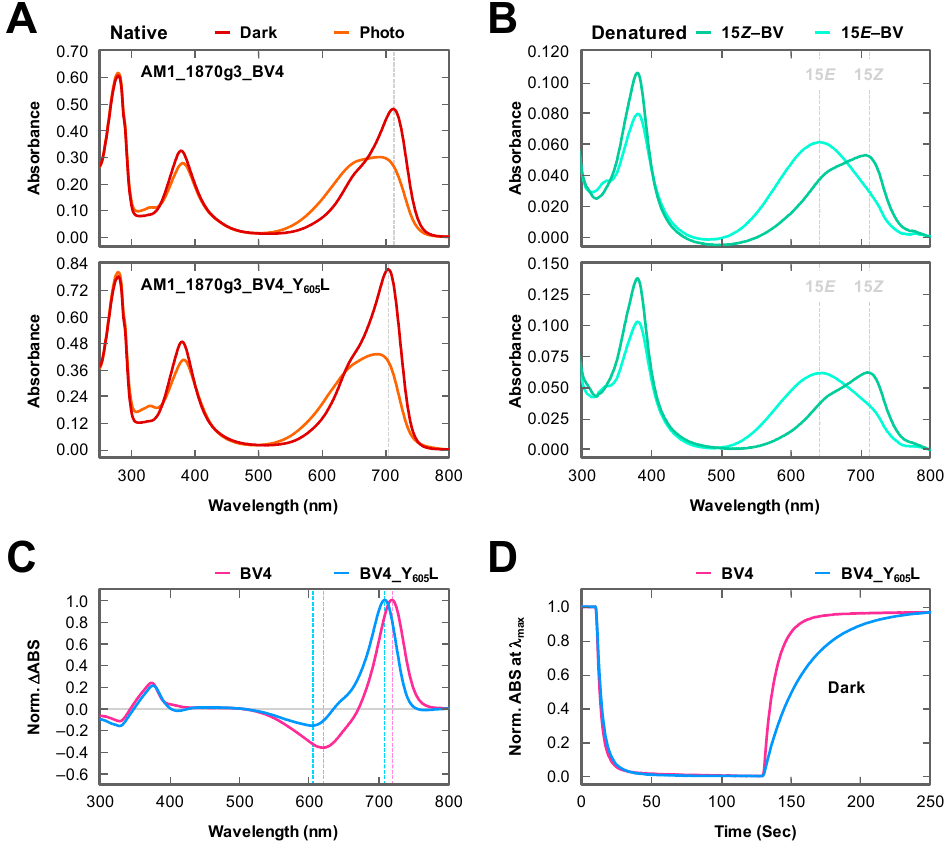
Figure 3. Photochemical properties of BV-bound AM1_1870g3_BV4 and BV4_Y 605 L. ( A ) Absorption spectra of AM1_1870g3_BV4 ( upper panel) and BV4_Y 605 L ( lower panel) in dark states (Pfr forms, dark red), and the photoproduct states (orange) under native conditions. These native spectra were recorded at 10 °C to repress dark reversion. Each peak of the Pfr form was indicated by the dotted line. ( B ) Absorption spectra of AM1_1870g3_BV4 ( upper panel) and BV4_Y 605 L ( lower panel) in dark states (15 Z forms, light green), and the photoproduct states (15 E forms, light blue) under acid-denatured conditions. The acid-denatured spectra were recorded at r.t. and compared with those of BV-bound AnPixJg2_BV4 [25]. ( C ) Normalized difference spectra (dark state—photoproduct state) of AM1_1870g3_BV4 (magenta) and BV4_Y 605 L (cyan). Positive peaks corresponding to the dark states and negative peaks corresponding to the photoproduct states were indicated by dotted lines (BV4, pink; BV4_Y 605 L, blue). ( D ) Photoconversion and dark reversion cycles of AM1_1870g3_BV4 (magenta) and BV4_Y 605 L (cyan). These processes between far-red light irradiation and dark incubation were monitored at the absorption maxima of each Pfr form (BV4, 718 nm; BV4_ Y 605 L, 708 nm) at 25 °C.